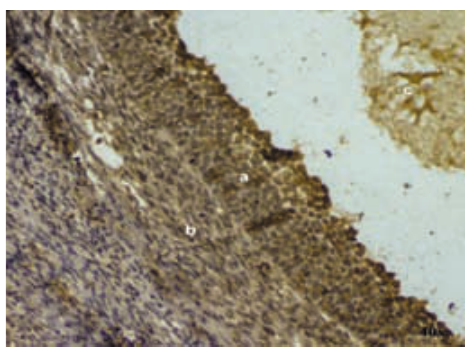
Fig.3 Antral follicle: (a) antrum, (b) mural granulosa cells, (c) theca interna cells (d) basal